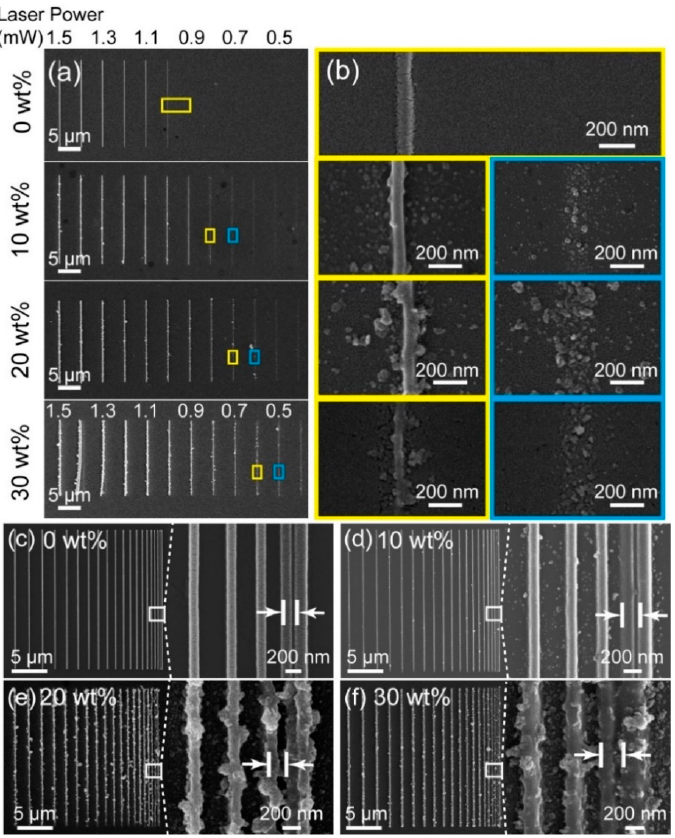
Figure 2. ( a ) The SEM image of the line structures at TiO 2 nanoparticle concentration of 0–30 wt% with different printing power ranging from 1.5 to 0.4 mW, respectively. ( b ) The enlarged structures corresponding to the yellow and blue boxes in ( a ). ( c – f ) The images relevant to the printing resolution of TiO 2 -based structures with concentrations of ( c ) 0 wt%, ( d ) 10 wt%, ( e ) 20 wt%, and ( f ) 30 wt%. The space between the adjacent lines was designed to vary from 2 to 0.2 μ m. The insets illustrate the zoomed-in results of the dashed-line areas.